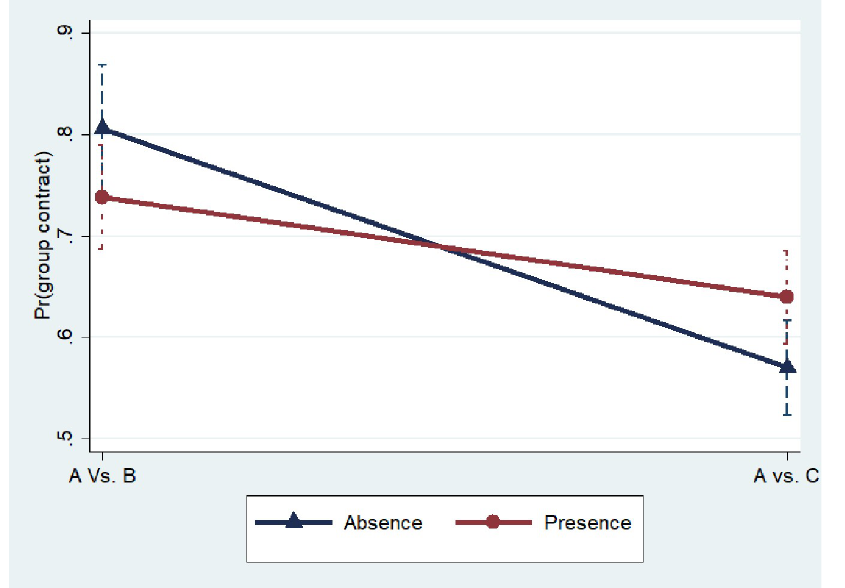
Fig 2. Predicted probabilities of group